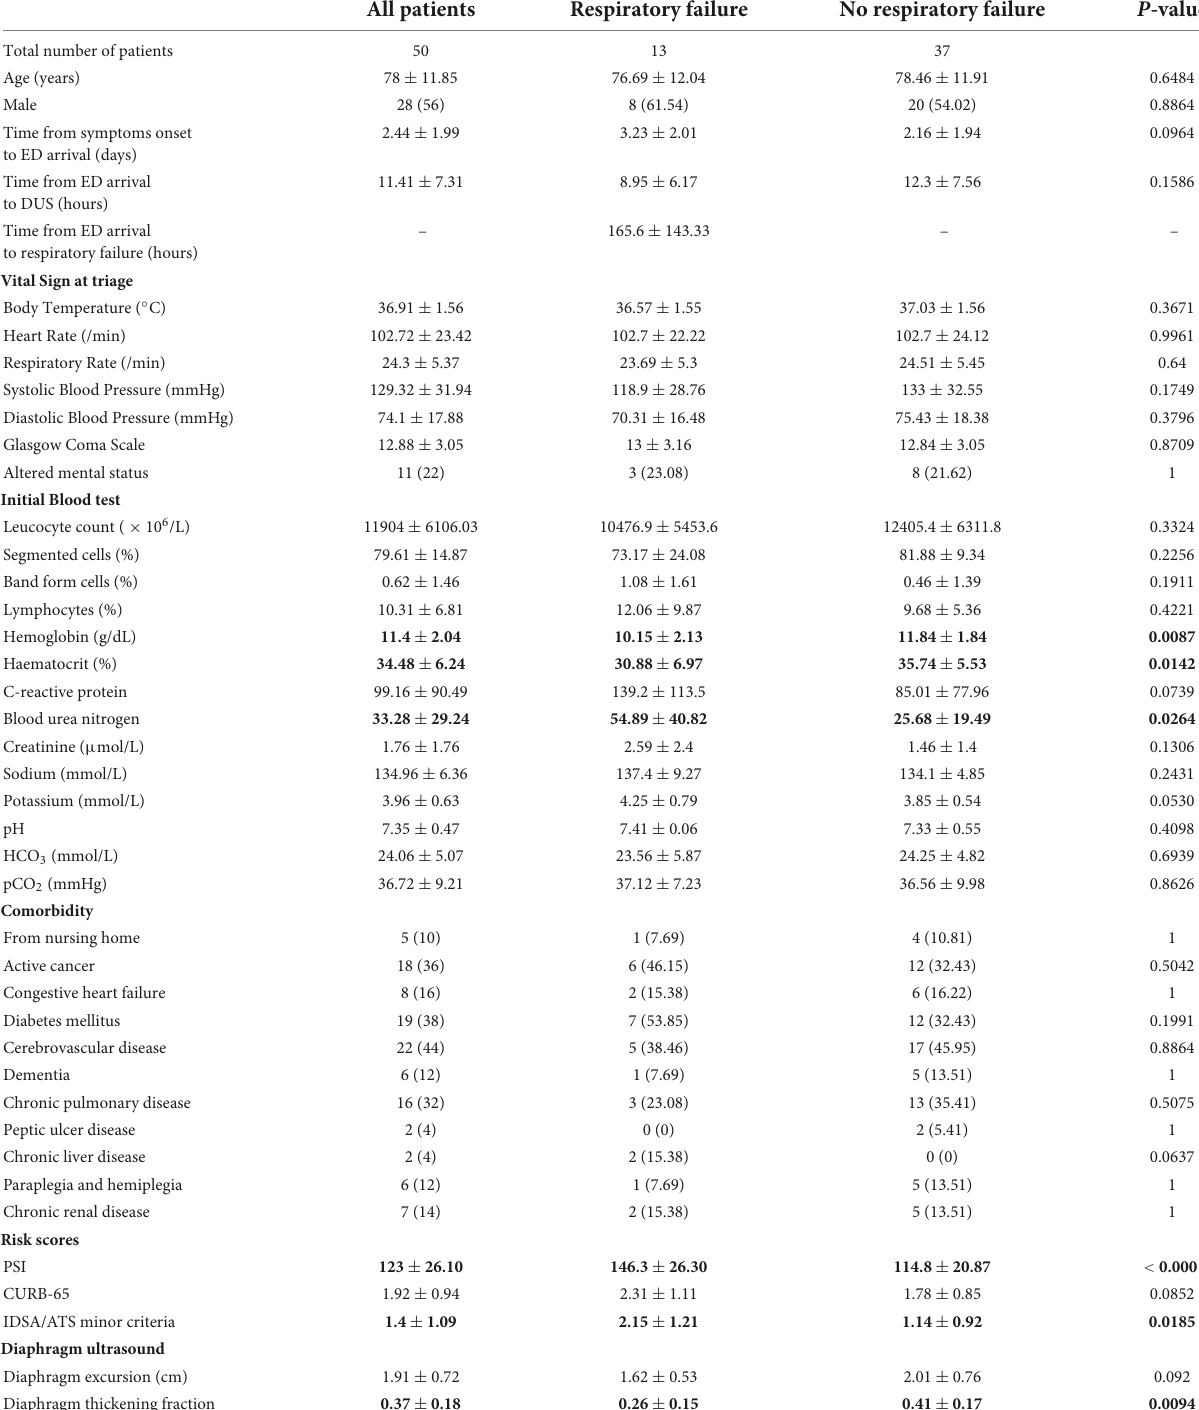
TABLE 1 Characteristics of community-acquired pneumonia (CAP) patients who developed respiratory failure versus those who did not. All